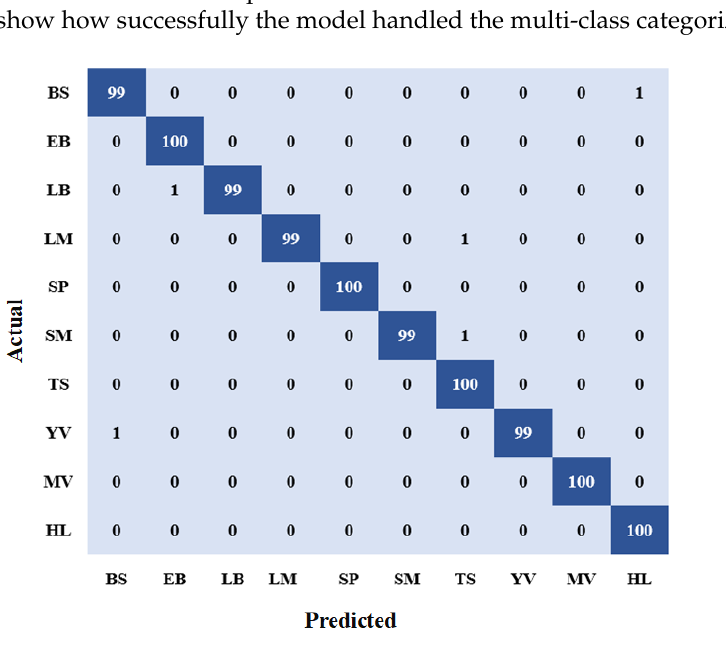
Figure 4. Confusion Matrix. ‘BS’, ‘EB’, ‘LB’, ‘LM’, ‘SP’, ‘SM’, ‘TS’, ‘YV’, ‘MV’, and ‘HL’ stand for bacterial spot, early blight, late blight, leaf mold, Septoria leaf spot, spider mite, target spot, yellow curl virus, mosaic virus, and healthy leaves,